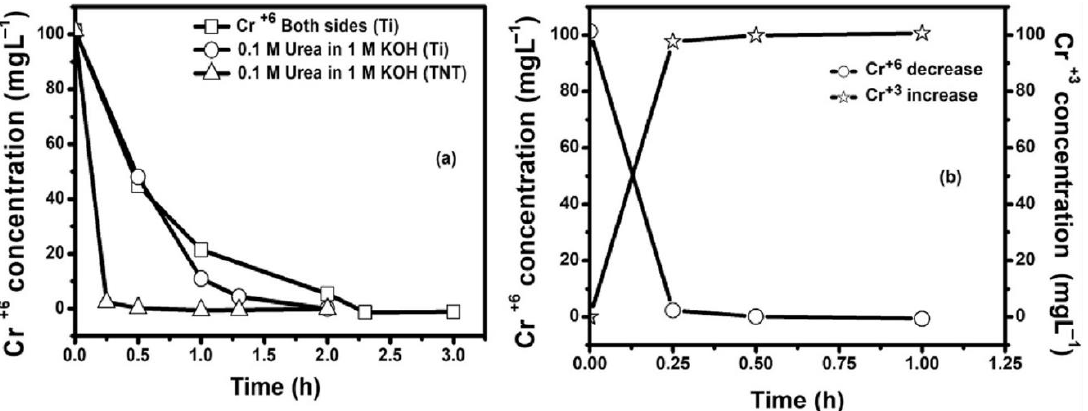
Figure 10. ( a ) Electrolytic reduction of 100 mgL − 1 Cr (VI) at 5 V with (□) Ti cathode with 100 mgL − 1 Cr on both sides, ( ○ ) addition of 0 .1M urea into 1M KOH at anode and with Ti cathode, (∆) addition of 0.1M urea into 1 M KOH at anode and with TNT cathode, ( b ) Cr (VI) reduction into Cr (III) on TNT with urea as anolyte additive (reproduced from [143] with permission from Elsevier™).